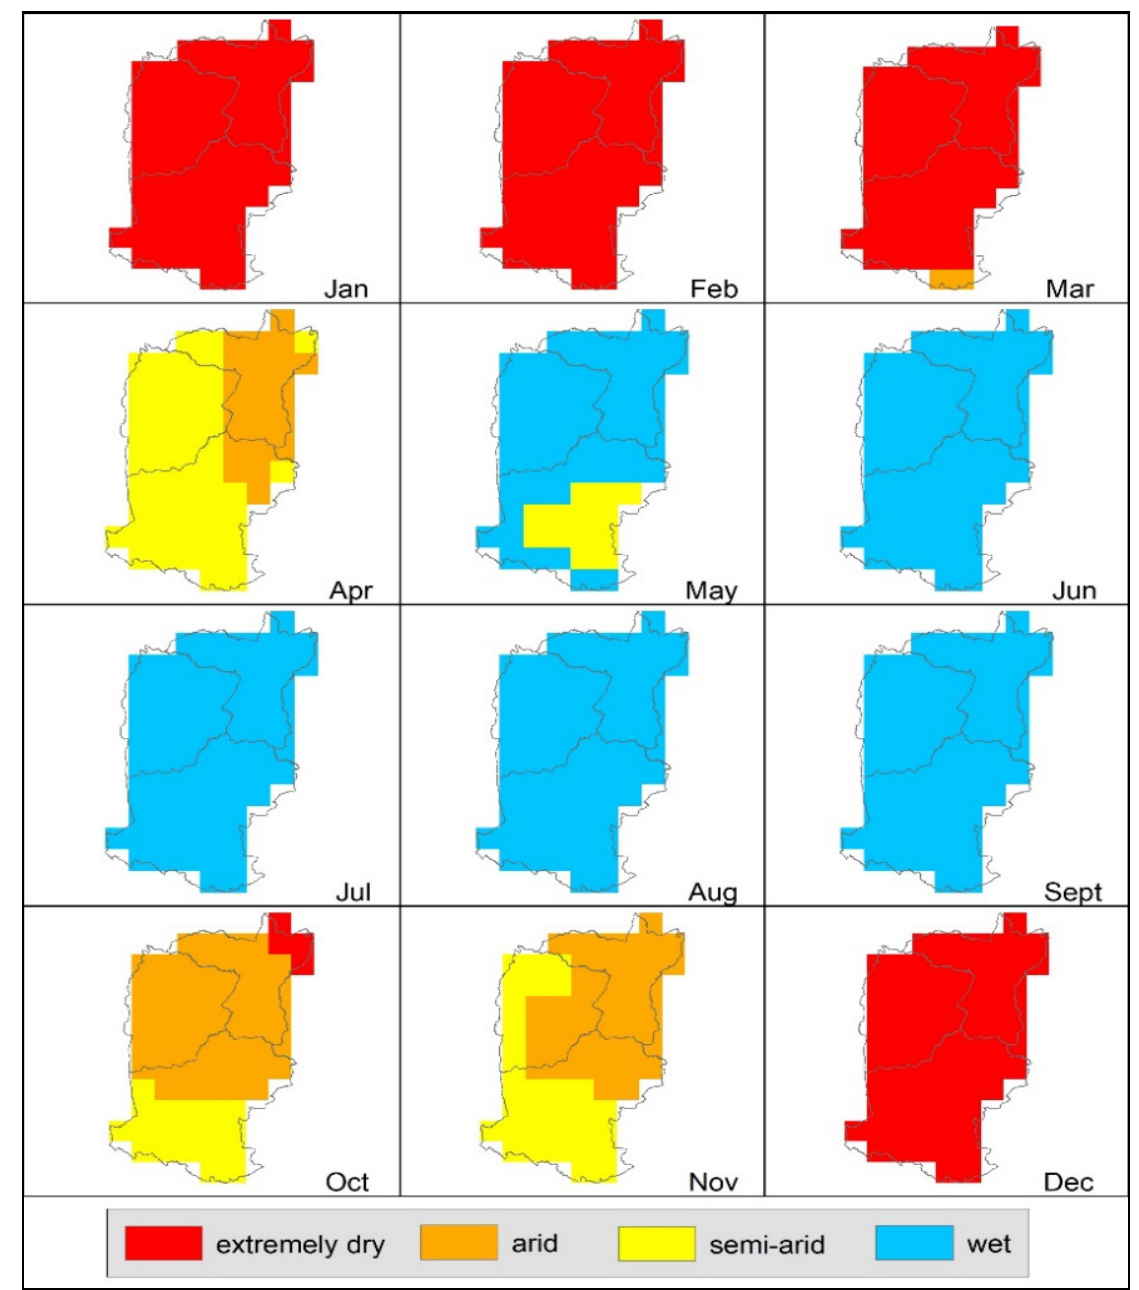
Figure 6. Thornthwaite aridity index map for 2005.